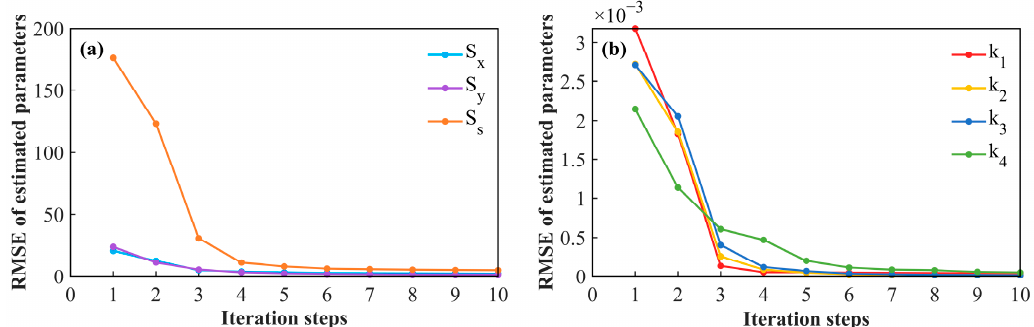
Figure 14. The RMSE of selected model parameters estimated in Case 3. ( a ) represents the RMSE of contaminant source characteristics at different iteration steps. ( b ) represents the RMSE of biochemical parameters at different iteration steps. Different coloured lines denote the RMSE of each parameter at different iteration steps.